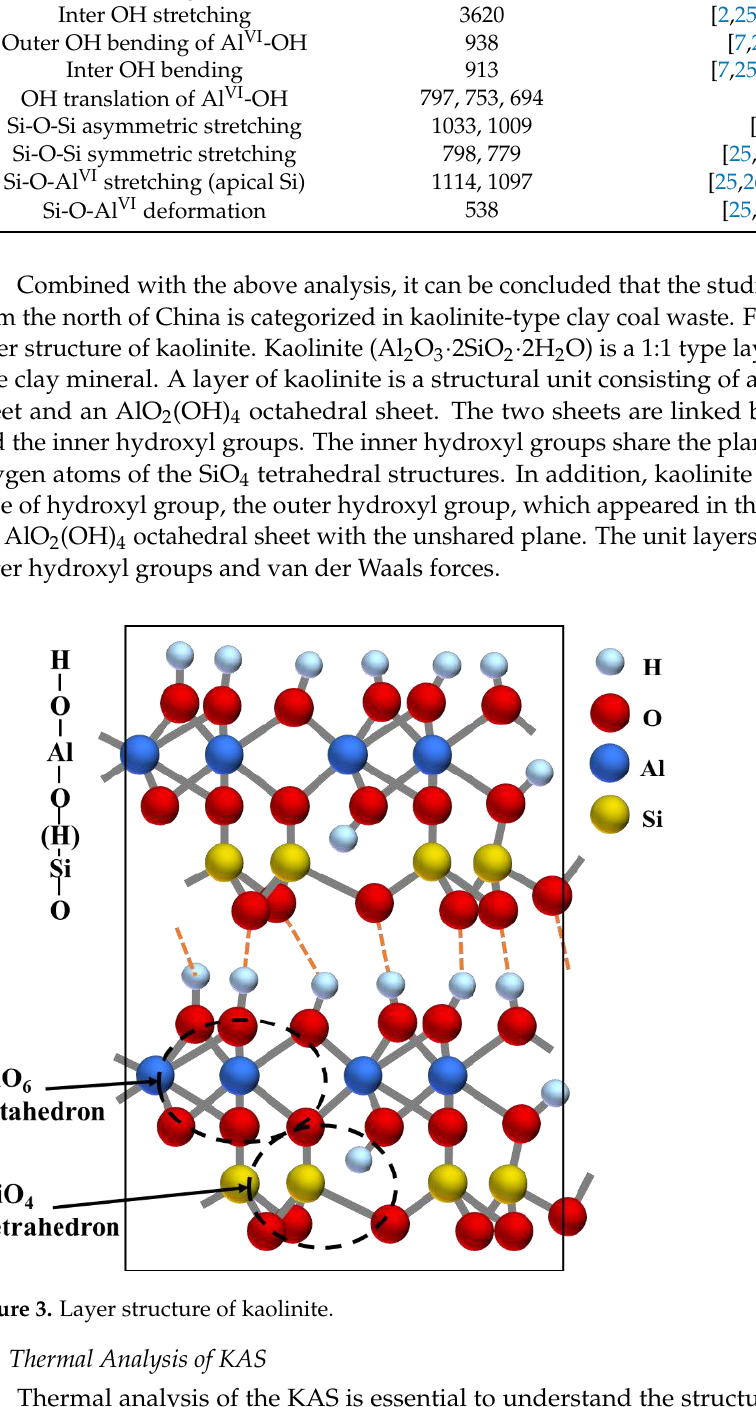
Figure 4. TGA ( a ), DTG ( b ), and DSC ( c ) curves of the KAS. 0